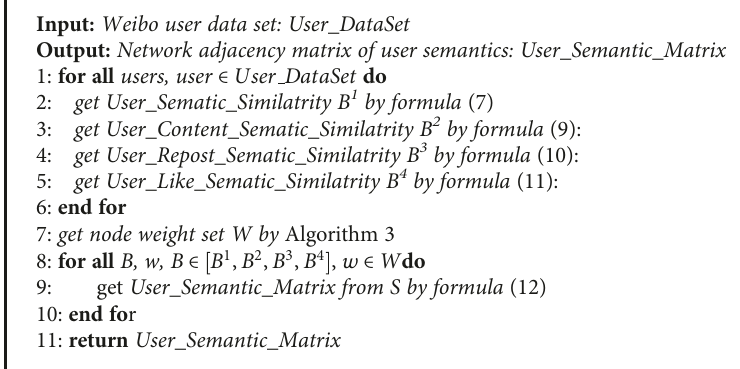
Algorithm 5: Network construction based on user